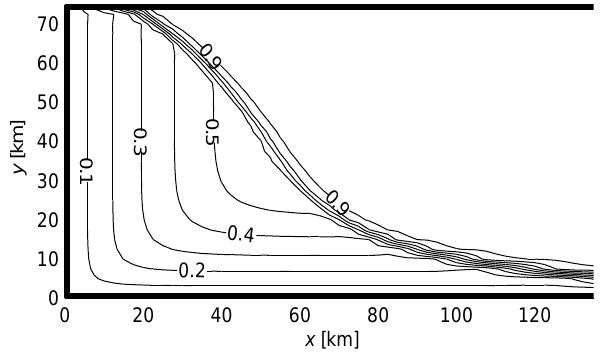
Fig. 5. Sea-ice concentration in the control experiment ( A ) after eight days of model integration. The polynya edge is visible as a sharp increase in concentration.